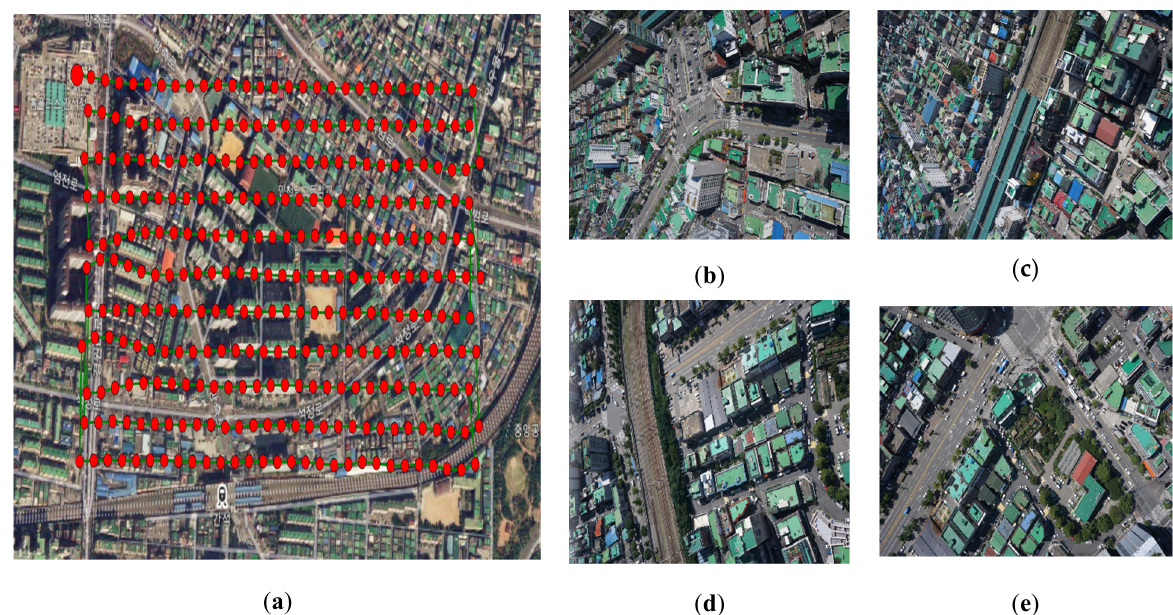
Figure 9. ( a ) Top view of UAV image positions and ( b – e ), images 57 to 60, which were removed after strip classification .